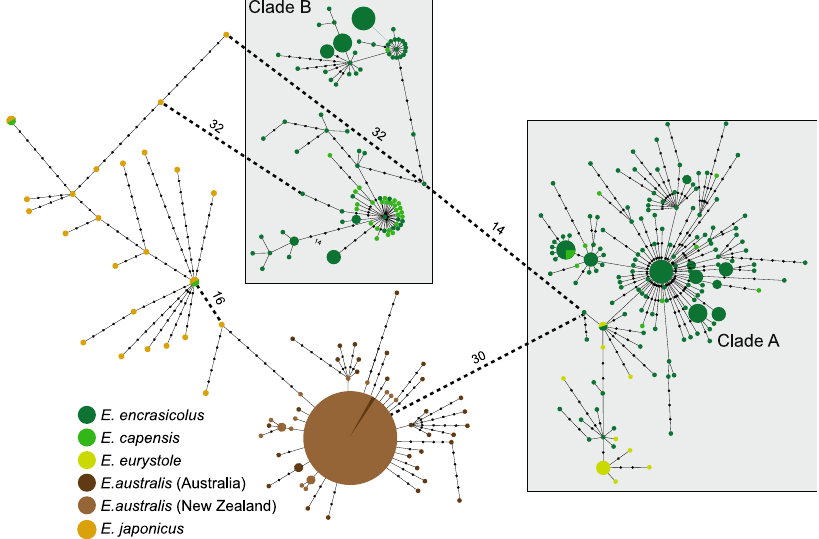
Figure 3. Minimum-spanning tree for the Old World Anchovies, based on the mitochondrial cytochrome b (1044 bp, 373 individuals). The colour and the size of the circles represent the geographic source (according to Fig. 1, with the exception of New Zealand haplotypes which are represented here in light brown) and frequency of each haplotype, respectively. The smallest colored circles represent a singleton haplotype. Black circles represent either extant unsampled sequences or extinct ancestral sequences. The length of the lines connecting haplotypes is proportional to the number of mutational differences separating the haplotypes, except when otherwise indicated.